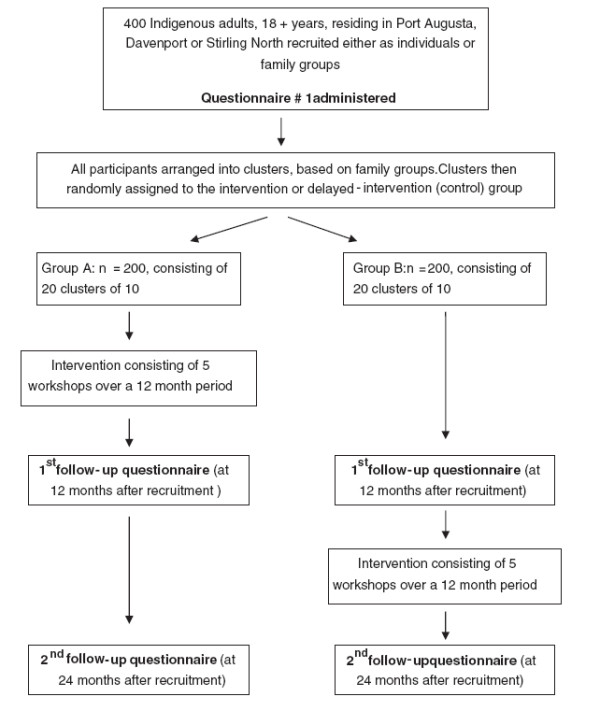
Study design schema.